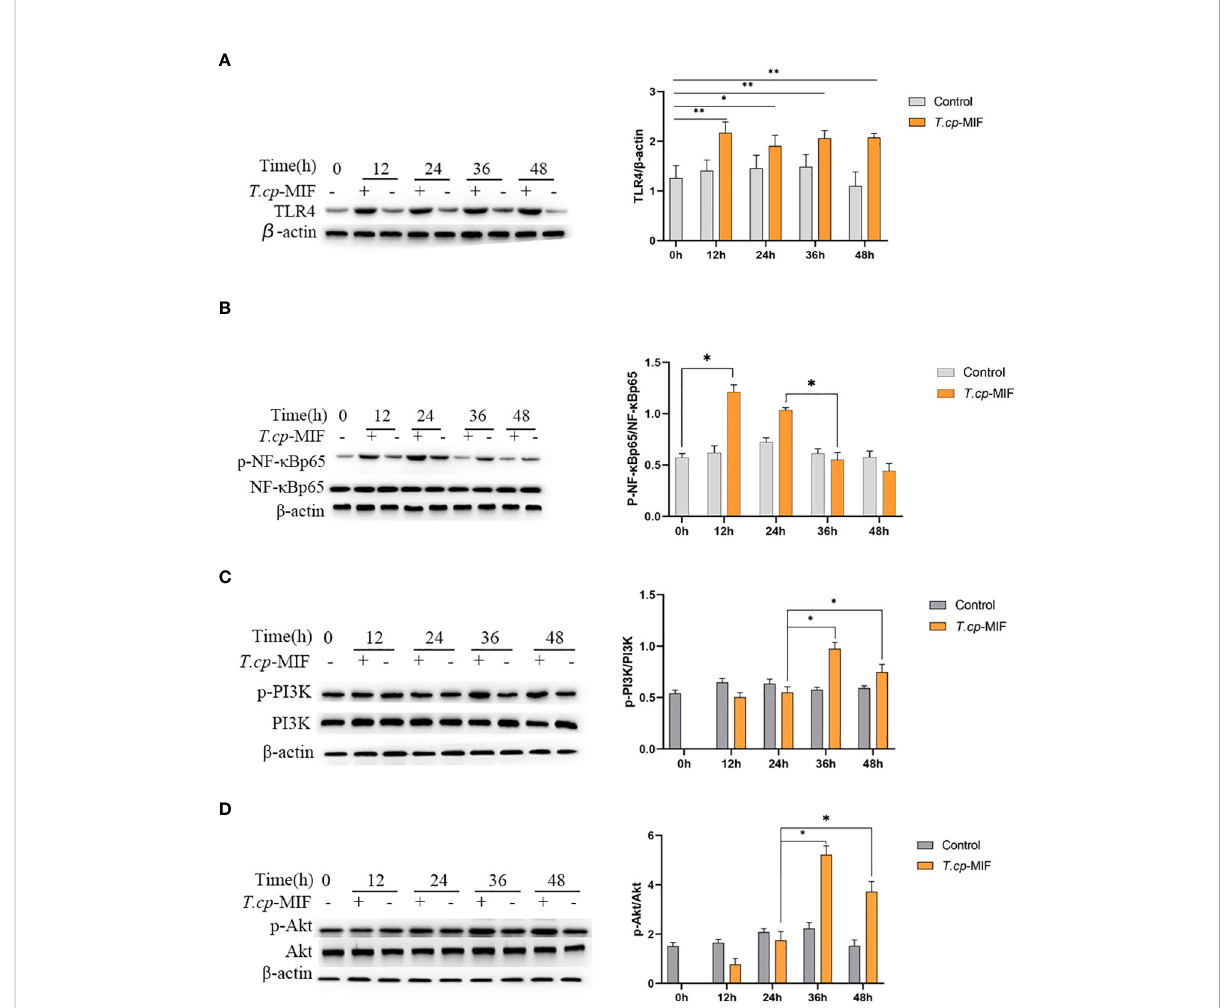
FIGURE 7 Effect of T.cp -MIF on the expression of macrophage polarization-related proteins in different time. (A – D) The protein expression levers of TLR4, NF- k Bp65, PI3K and AKT were analyzed by western blot and normalized against b -actin expression. * indicated P <0.05. Results are showed as the mean of three times of independent experiments ( x ̄ ±SD,